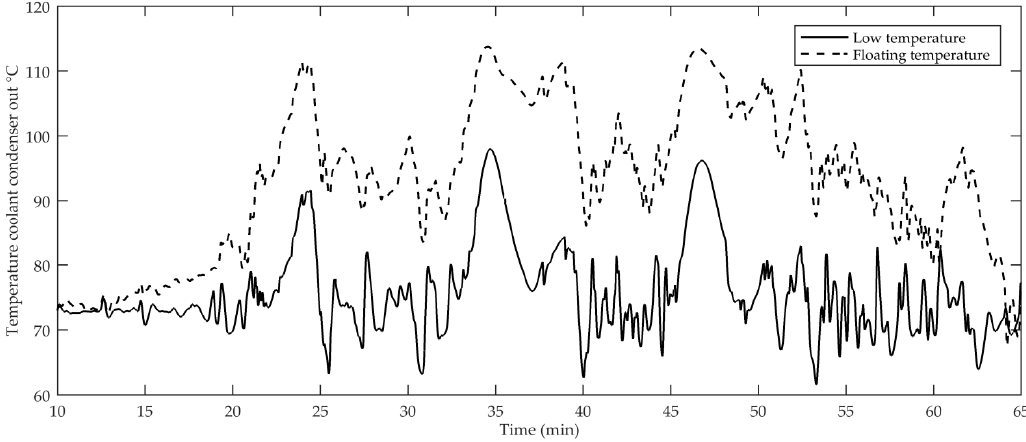
Figure 12. Temperature coolant condenser out, transient simulation result.